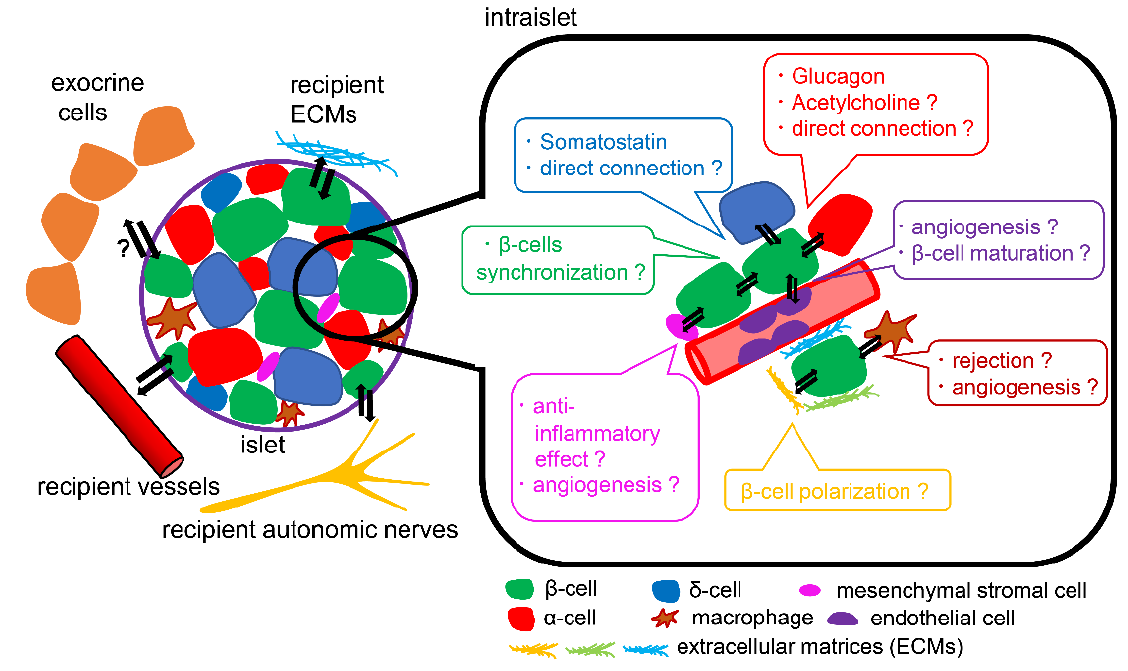
Figure 3. Schema of islet microenvironment. The interactions of β -cells with α -cells, δ -cells, endothelial cells, mesenchymal stromal cells, macrophages, and ECMs can affect β -cell function and survival. The differences in the interactions with microenvironments between transplanted hPSCs-derived islets and transplanted human islets remain unclear.